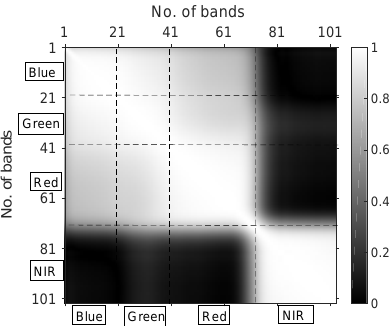
Figure 3. Absolute value of correlation matrix: lines are to separate different